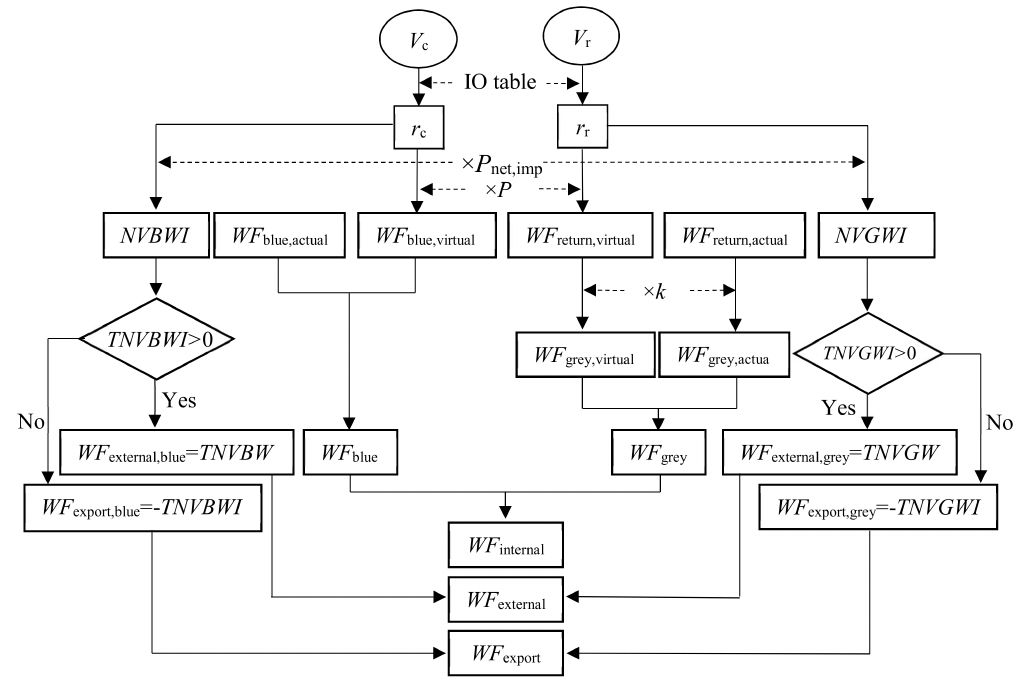
Figure 1. Calculation flow chart. WF: Water footprint; NVBWI/NVGWI : Net virtual blue/grey water import; TNVBWI/TNVGWI : Total net virtual blue/grey water import; k: Conversion coefficient of grey water footprint; V c / V r : Water consumption/Return water; r c / r r : Total water consumption